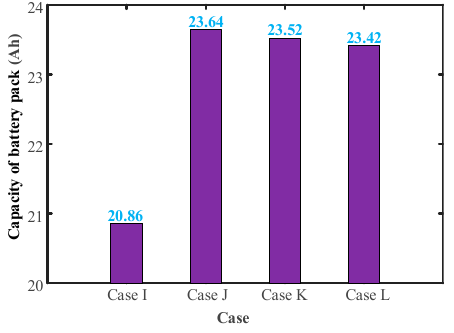
Figure 10. Battery pack capacity (static).